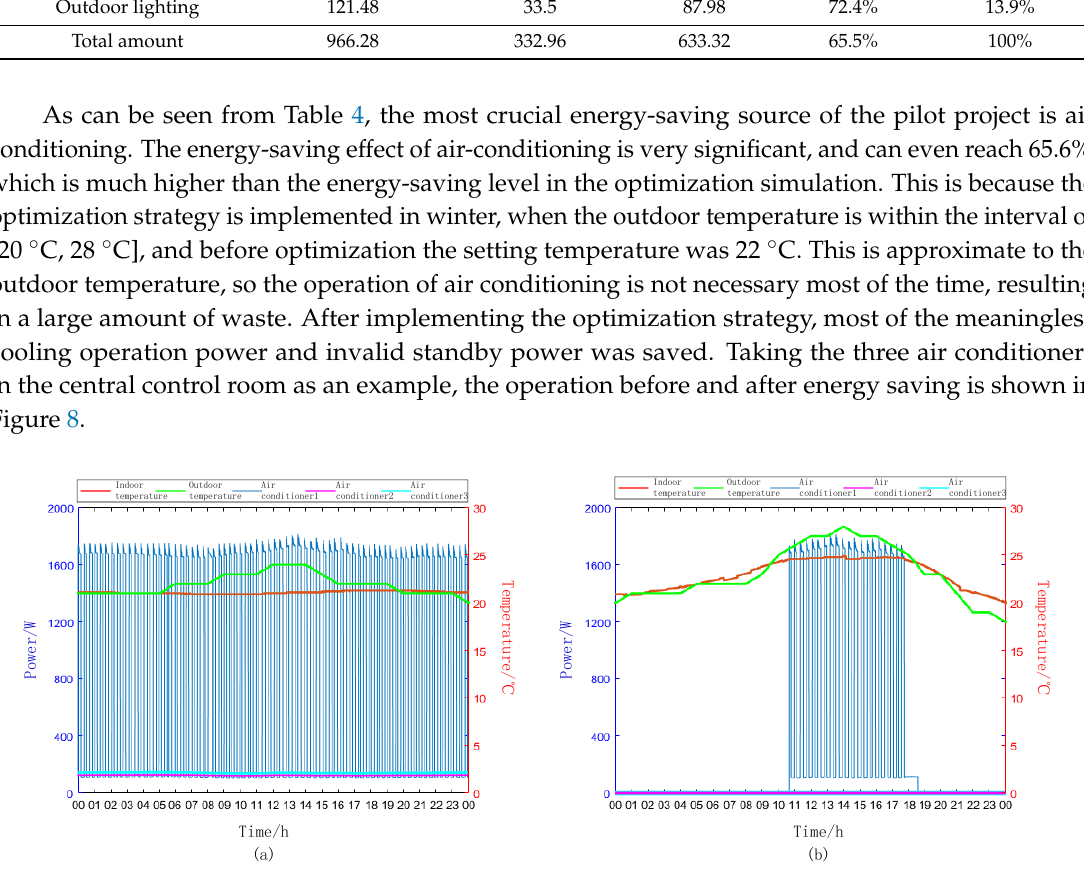
Figure 8. Energy saving optimization for air-conditioners in the central control room. ( a ) The operation of air conditioners and temperature before optimization. ( b ) The operation of air conditioners and temperature after optimization.